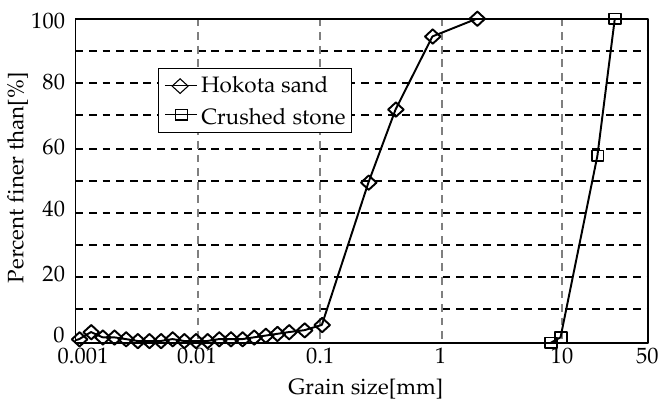
Figure 6. Grain size distribution of Hokota sand for levee material in all cases and crushed stone for drain layer of the LDR levee.